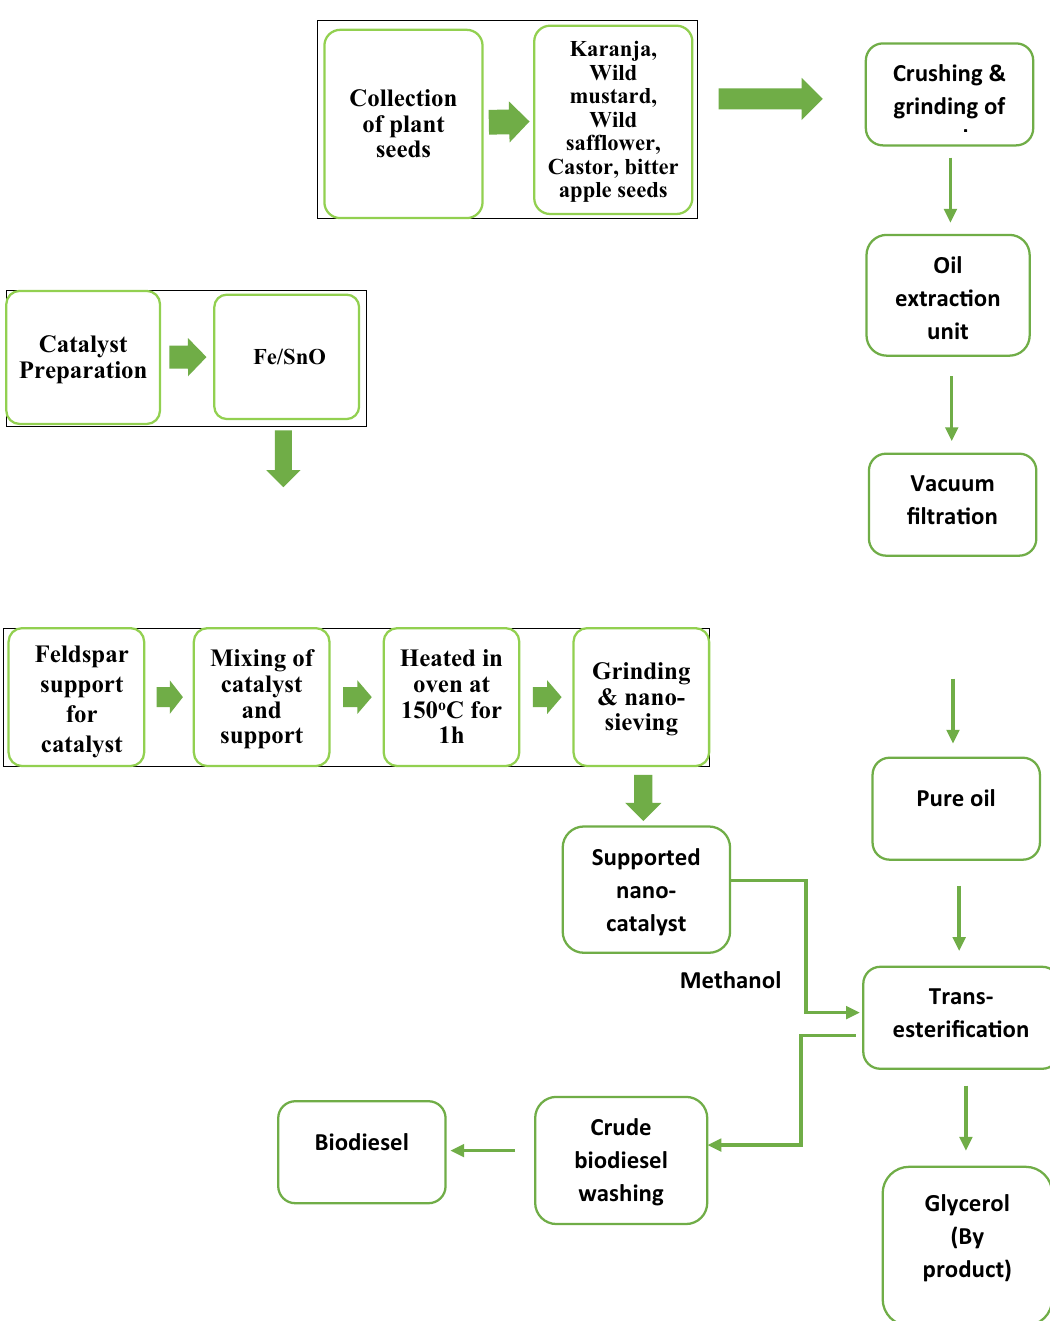
Figure 1. Schematic representation for biodiesel production from five different non-edible oils using Fe/SnO/ Feldspar nano-magnetic